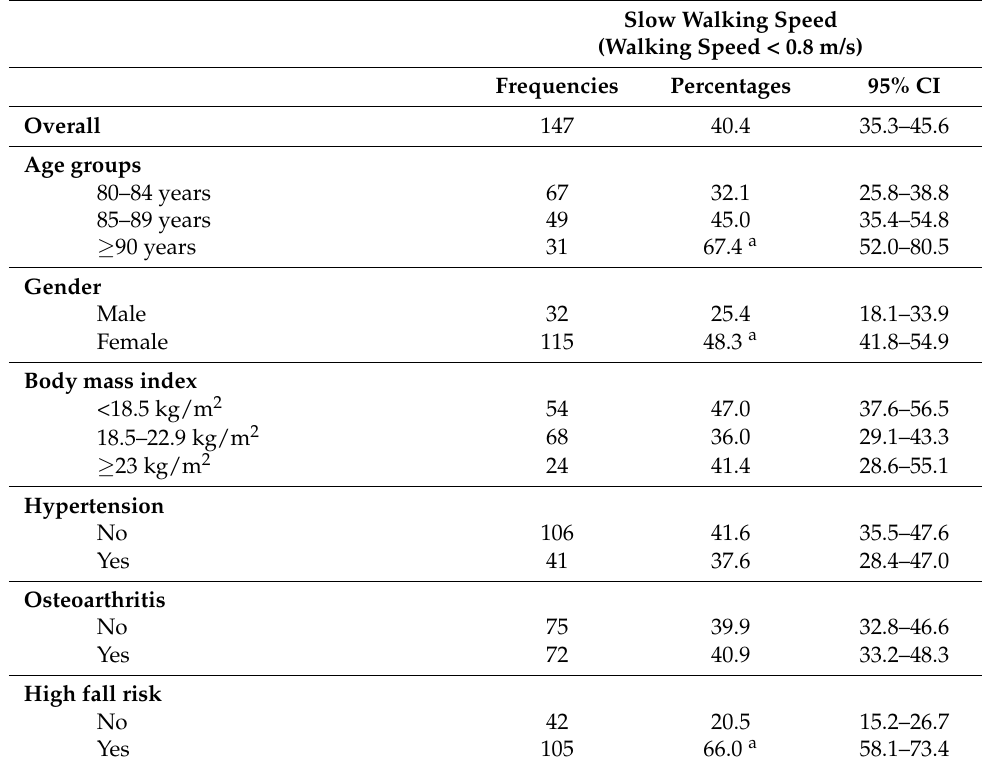
Table 3. Prevalence of a slow walking speed among the study participants (n =